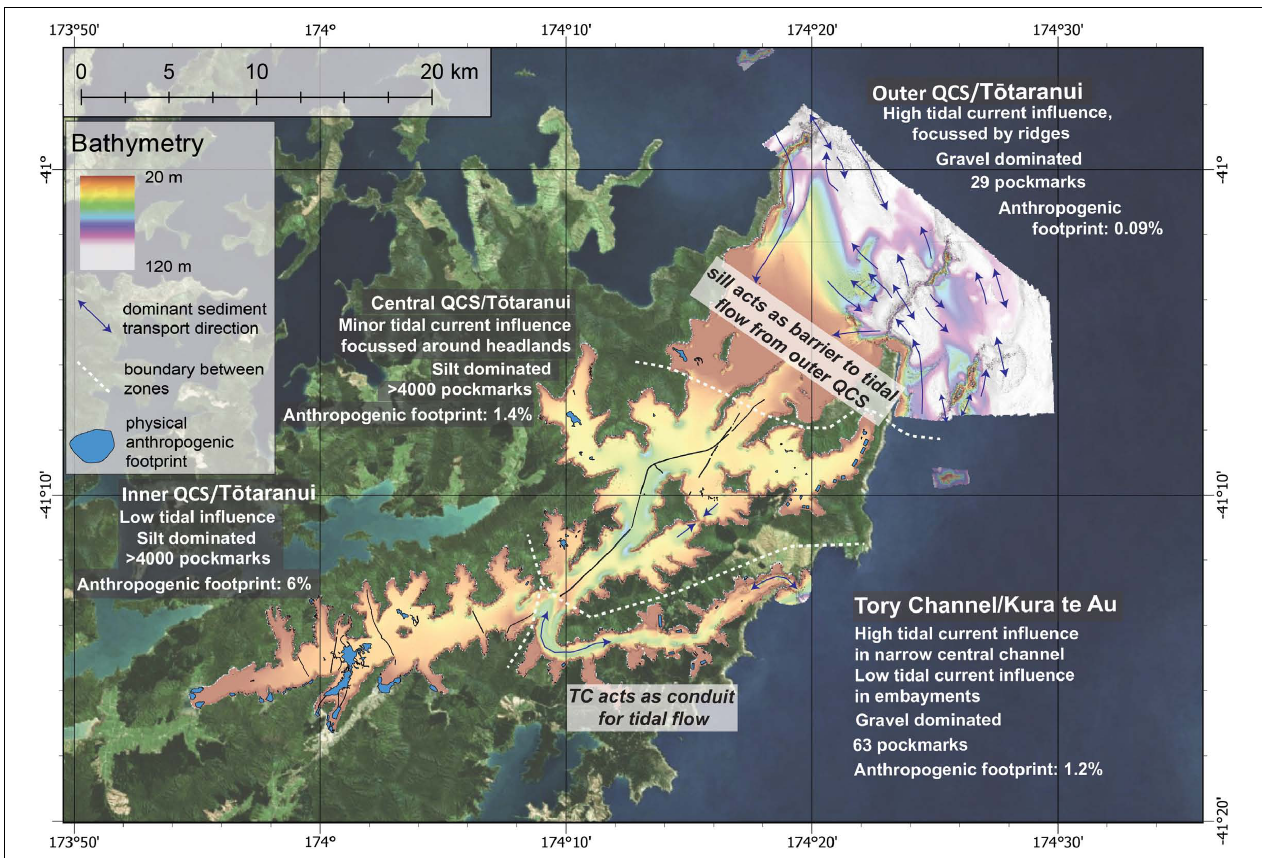
FIGURE 11 | Regional view of the QCS and TC bathymetry (2 m resolution). The study area is divided into geographic zones: inner QCS, central QCS, outer QCS and TC. Our findings show that each zone has distinctive distributions and concentrations of natural and anthropogenic features (annotated), demonstrating the range and variability of processes shaping the seafloor in each zone. White dashed lines represent the boundary between these zones. Navy blue arrows show the dominant sediment transport direction as interpreted from seafloor